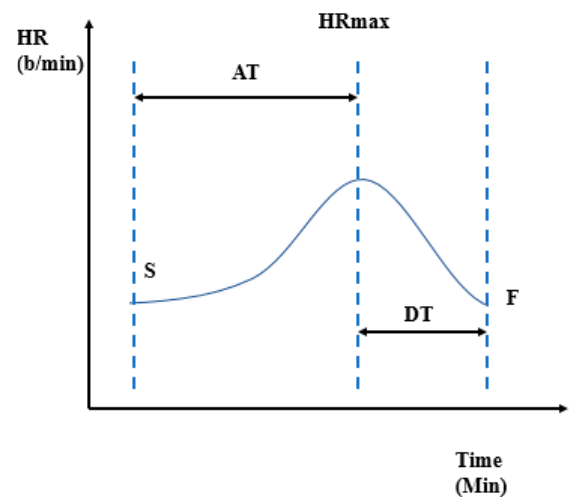
Figure 1. Graphic description of heart rate recovery index (HRRI) = acceleration time (AT)/deceleration time (DT). HR = heart rate; HRmax = maximum heart rate; S = start exercise; F = final